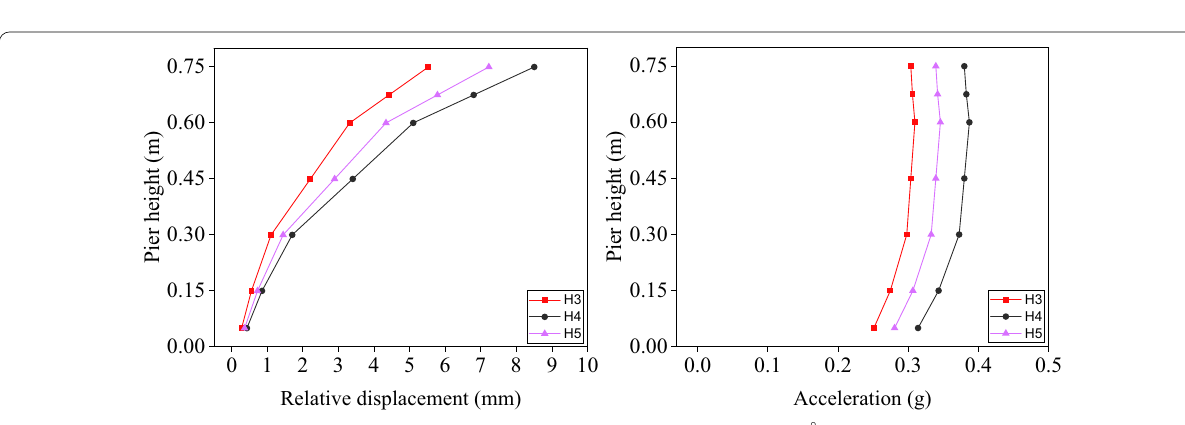
Fig. 11 Peak relative displacement and peak acceleration of the pier under structure orientation ( 45